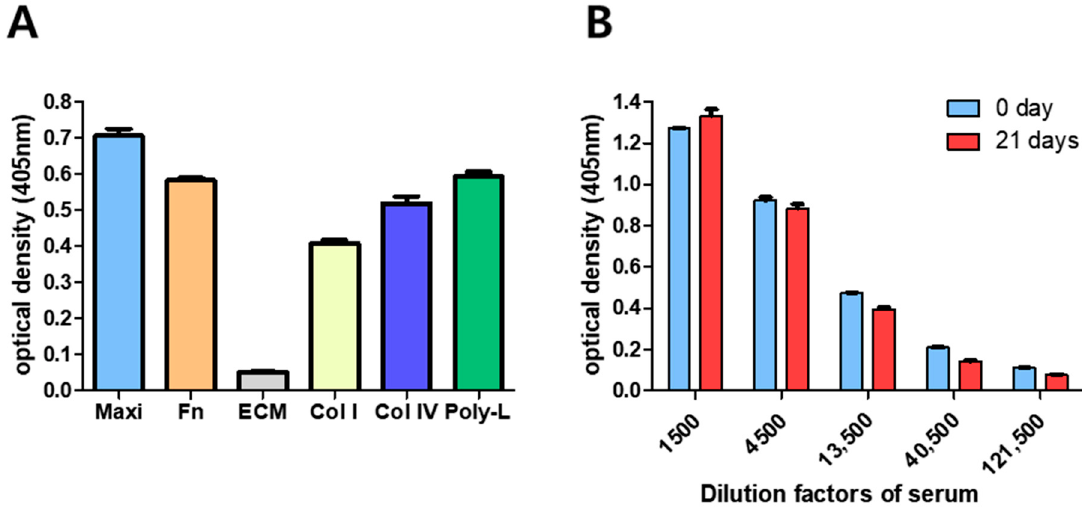
Figure 1. Optimization of group B Streptococcus (GBS) polysaccharide (PS) immobilization condition. ( A ) Binding efficiency of GBS Ia PS to different 96-well plates. GBS Ia PS (1 µ g/well) was immobilized in indicated 96-well plates at 37 ◦ C for 5 h. Maxi, Maxibinding plate; Fn, fibronectin coated plate; ECM, extracellular matrix (ECM)-coated plate; Col I, collagen type I coated plate; Col IV, collagen type IV coated plate; Poly-L, poly-D-lysine coated plate. ( B ) Comparison of stability of GBS PS in Maxibinding plates for 21 days. GBS Ia PS (1 µ g/well) was immobilized in 96-well plates at 37 ◦ C for 5 h and then stored at 4 ◦ C for 21 days. After blocking with 10% fetal bovine serum (FBS), rabbit anti-GBS Ia antiserum (1:5000) was added and bound antiserum was detected using anti-rabbit IgG-horseradish peroxidase (HRP) secondary antibody (1:10,000).